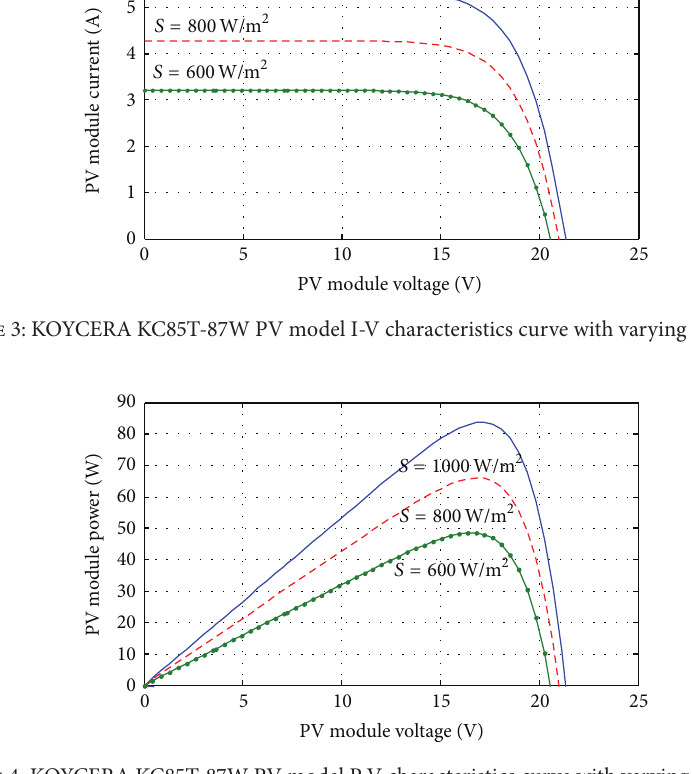
current, 𝐾 , the Boltzmann constant = 1.38 × 10 −23 ( J / K ) , 𝑞 , the charge of electron = 1.6 × 10 −19 (𝐶) , 𝑇 is the cell